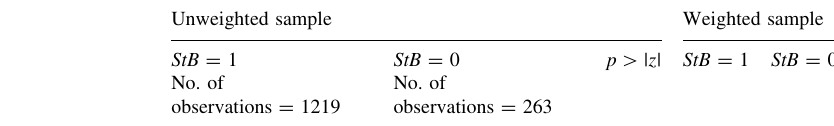
Table 5 Main multivariate findings—controlling for observable auditor characteristics and determinants of firm-level auditor choice Unweighted sample Weighted